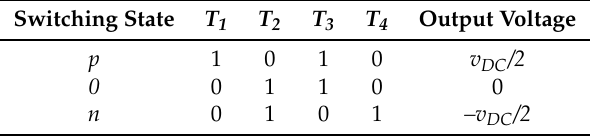
Table 1. Switching states for the 3L-ASYM topology.